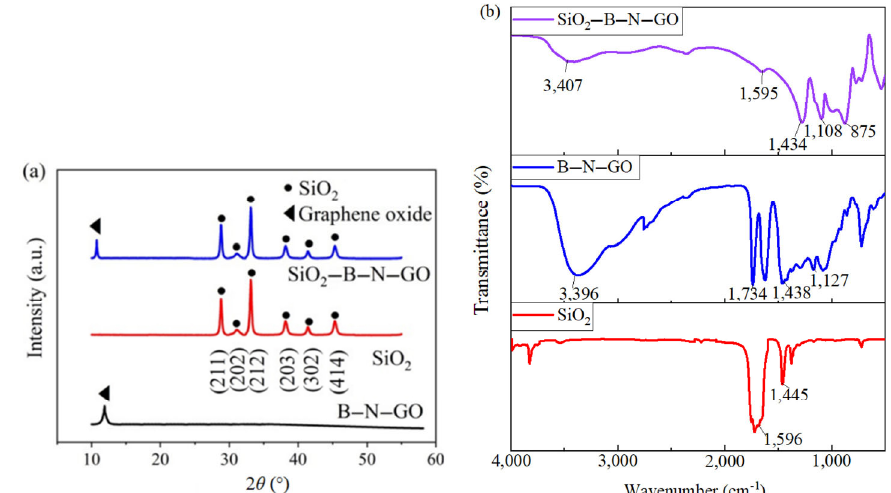
Fig. 3 (a) XRD images and (b) infrared spectra of the